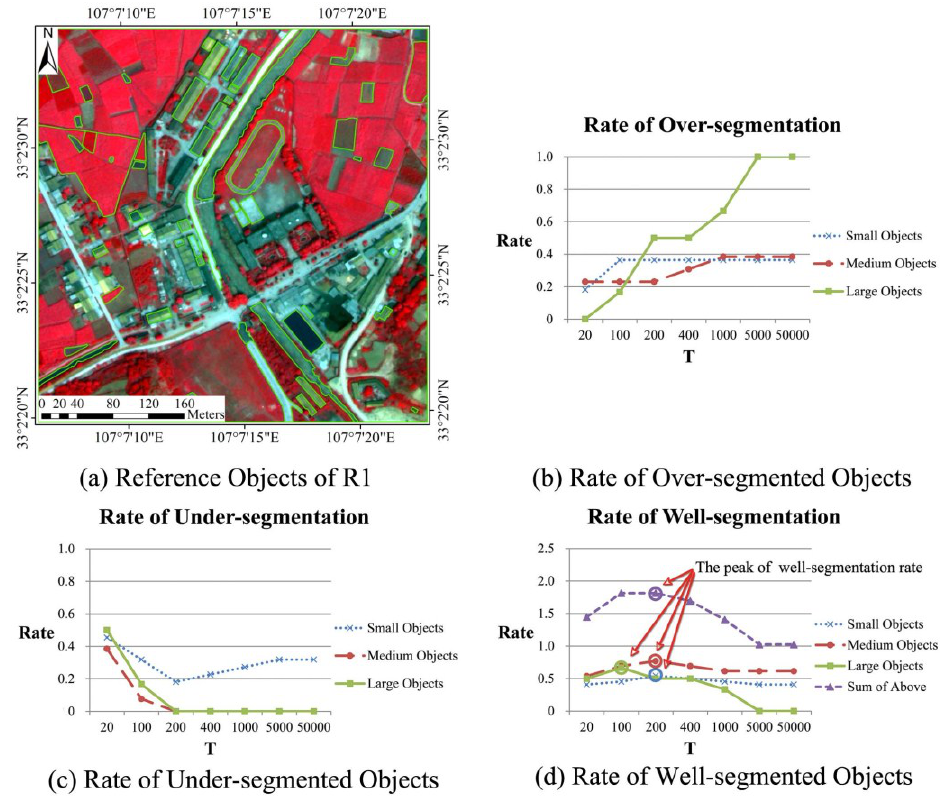
Figure 8. ( a ) The reference objects of R1, including 22 small objects (100–999 pixels), 13 medium size objects (1000–4999 pixels) and 6 large objects (more than 5000 pixels); ( b – d ) display the rates of over-segmented, under-segmented and well-segmented objects,